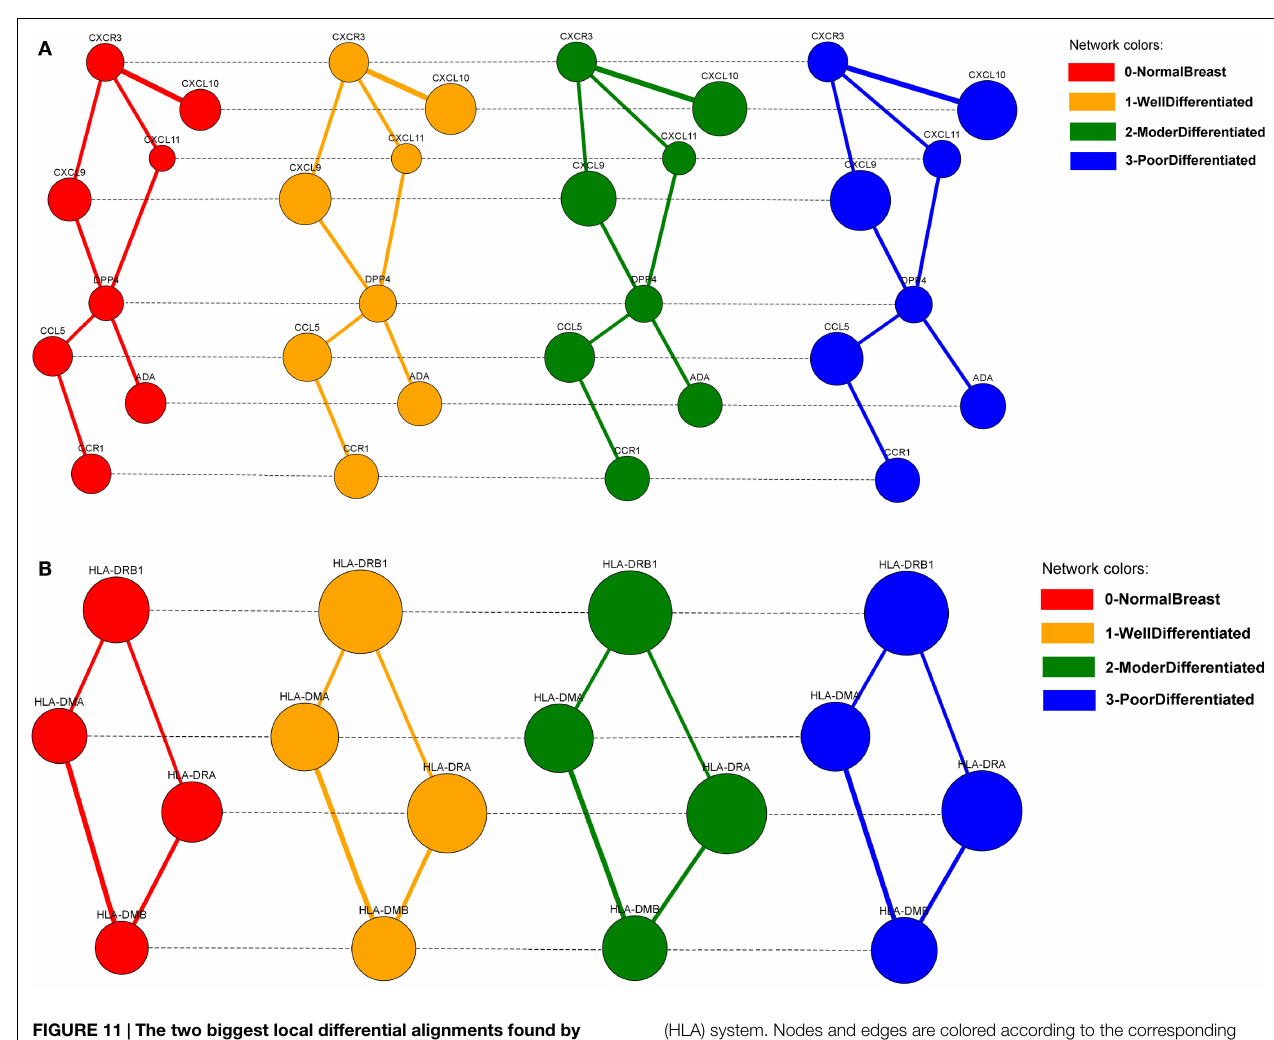
FIGURE 11 | The two biggest local differential alignments found by the Adaptive GASOLINE for the TS-PPI networks of normal breast cells (grade 0), well-differentiated cells (grade 1), moderately differentiated cells (grade 2), and poorly differentiated cells (grade 3) . (A) A complex of chemokine proteins. (B) The Human Leukocyte Antigen